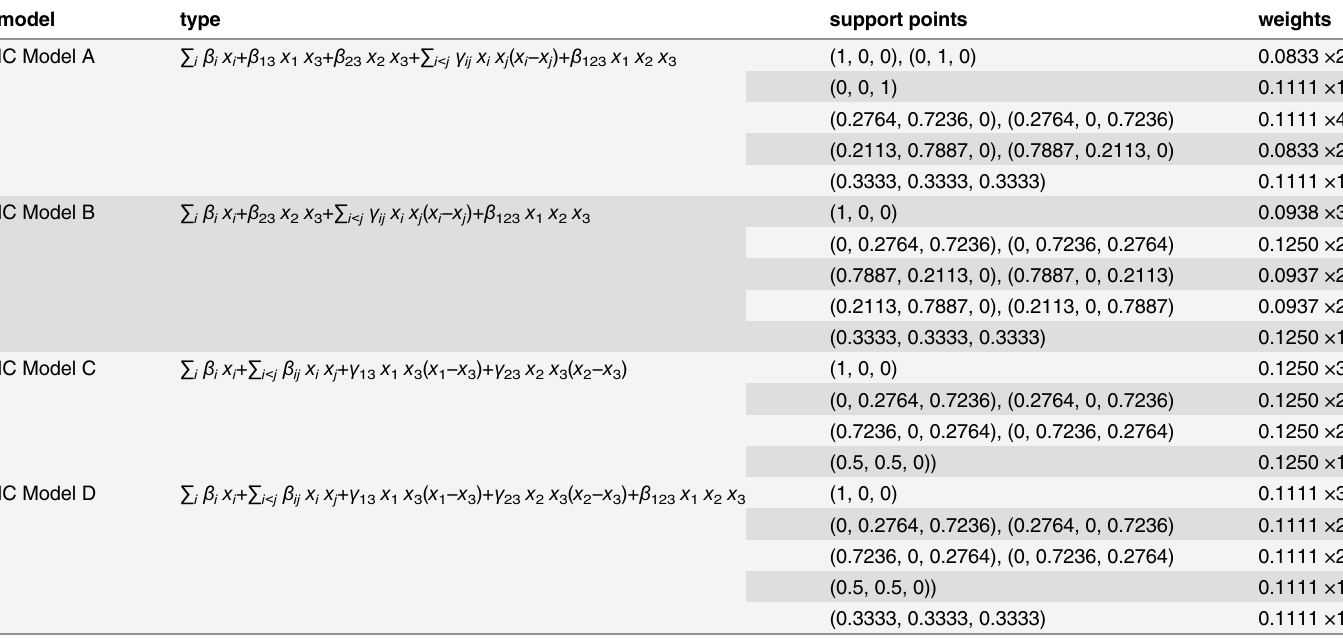
Table 1. ProjPSO-generated D -optimal designs for submodels from Scheffé polynomial models with 3 factors. model